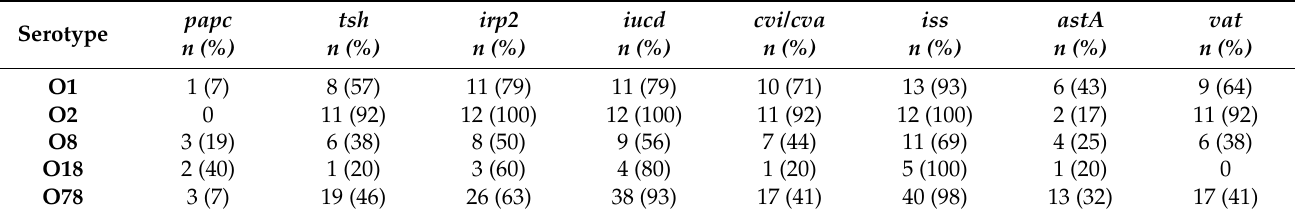
Table 7. The presence of virulence genes in E. coli serotypes.